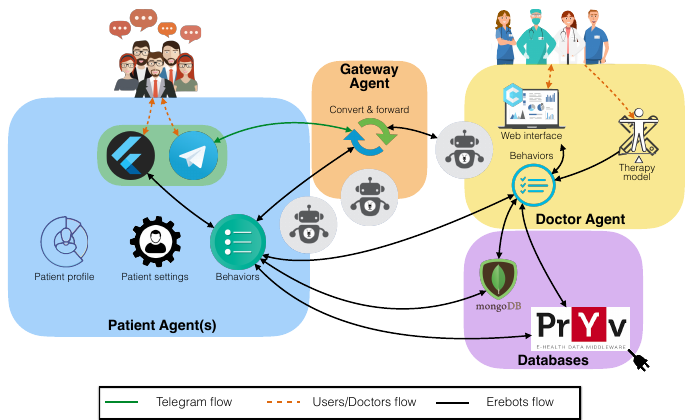
Figure 2. EREBOTS architecture and interactions containerized via Docker.